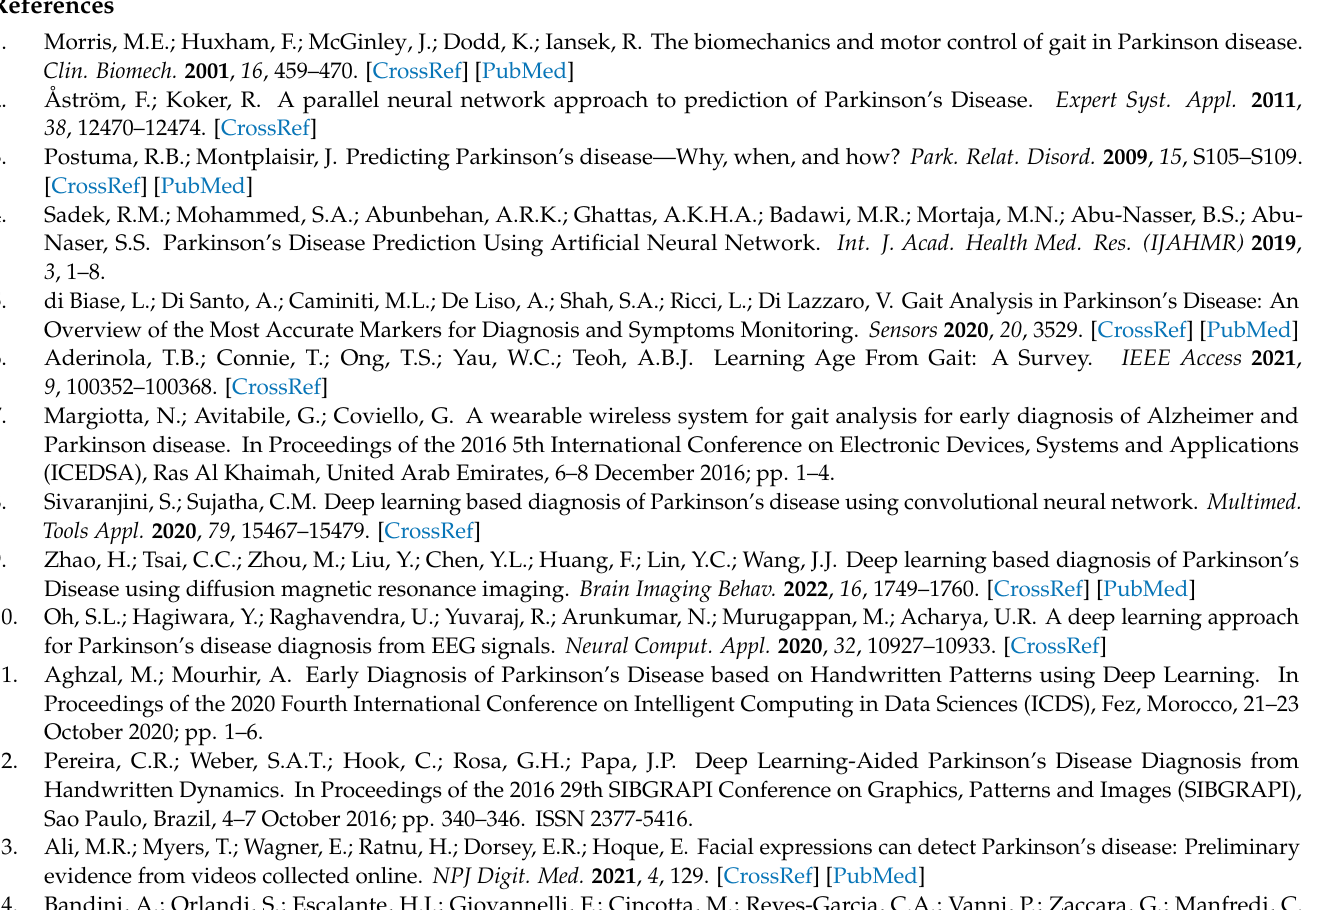
Figure A2. Features analysis by class (front view).